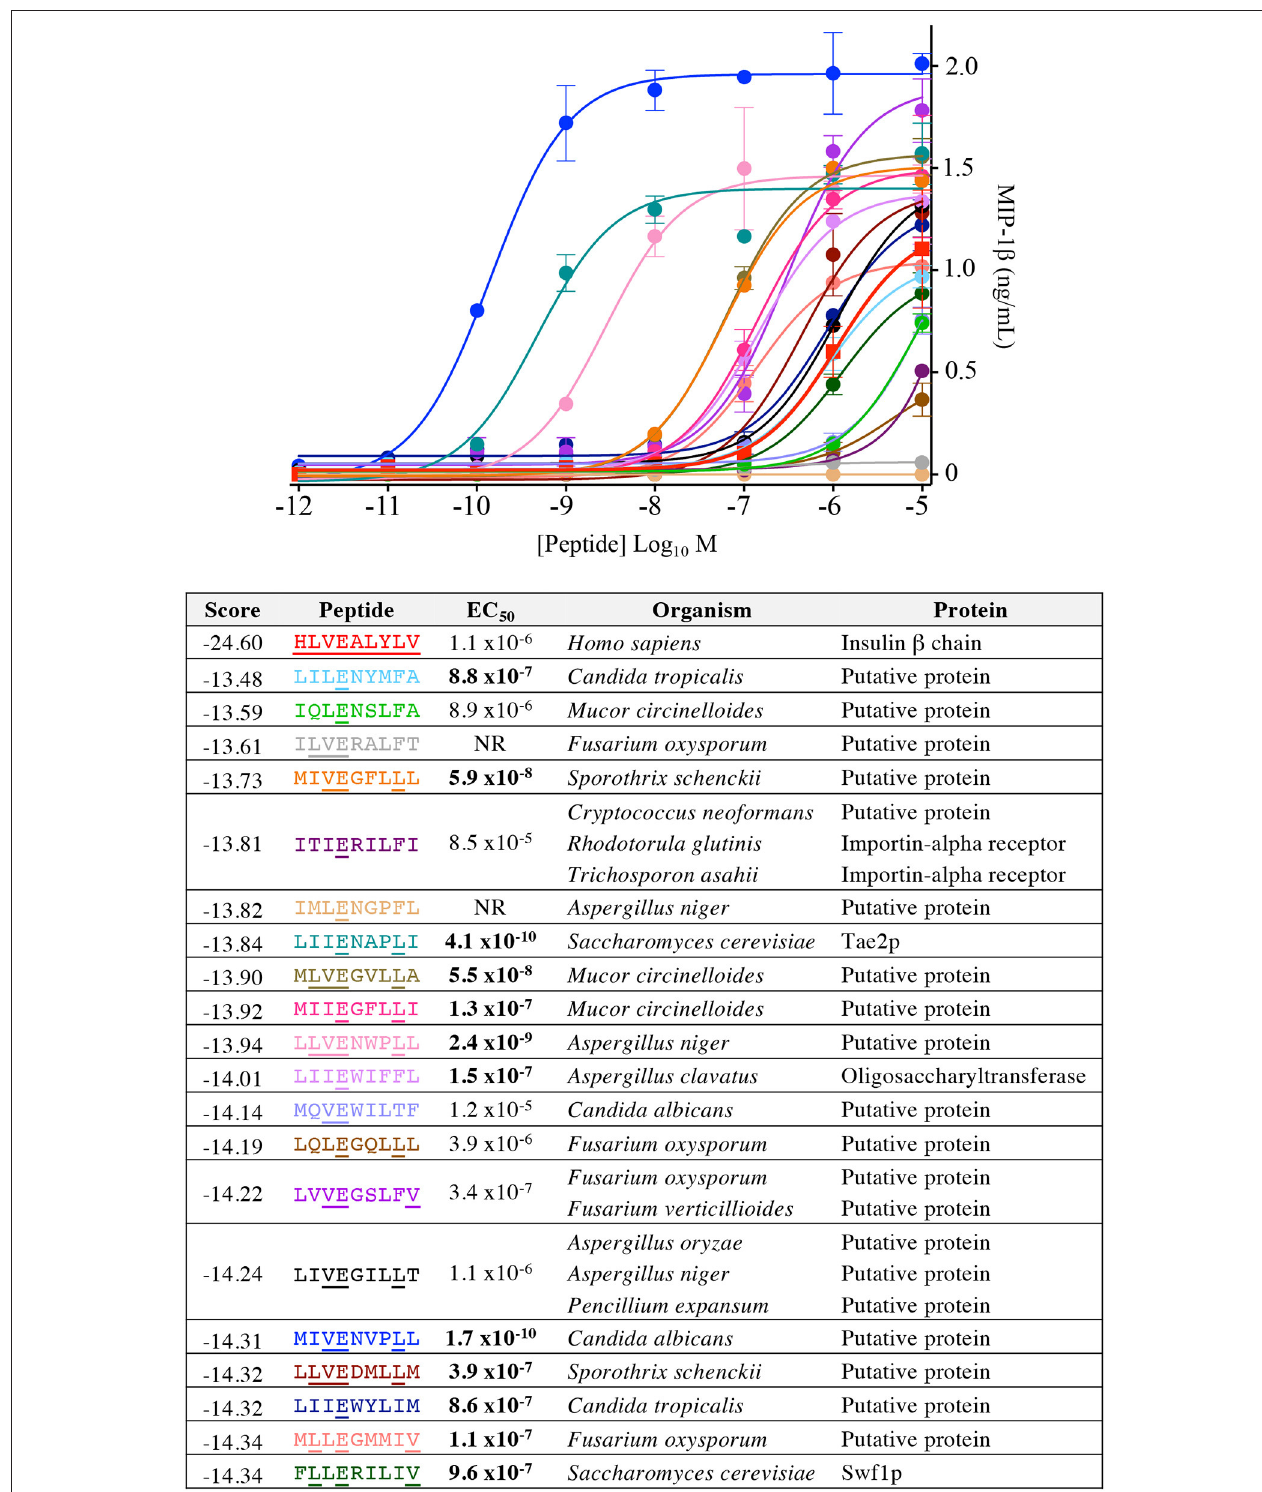
FIGURE 8 | InsB4 recognizes fungal peptides with increased sensitivity relative to index insulin peptide. The 20 top-scoring peptides from fungal species were tested overnight for activation on InsB4 by MIP-1 β ELISA. The likelihood scores and EC 50 of peptide (M) activation are shown. Putative proteins are the product of predicted open reading frames from the genome sequence of the species indicated. NR, no T-cell response. Bold EC 50 more potent than the index peptide. Amino acid residues that are the same for each fungal peptide and the insulin index peptide (HLVEALYLV) are underlined.